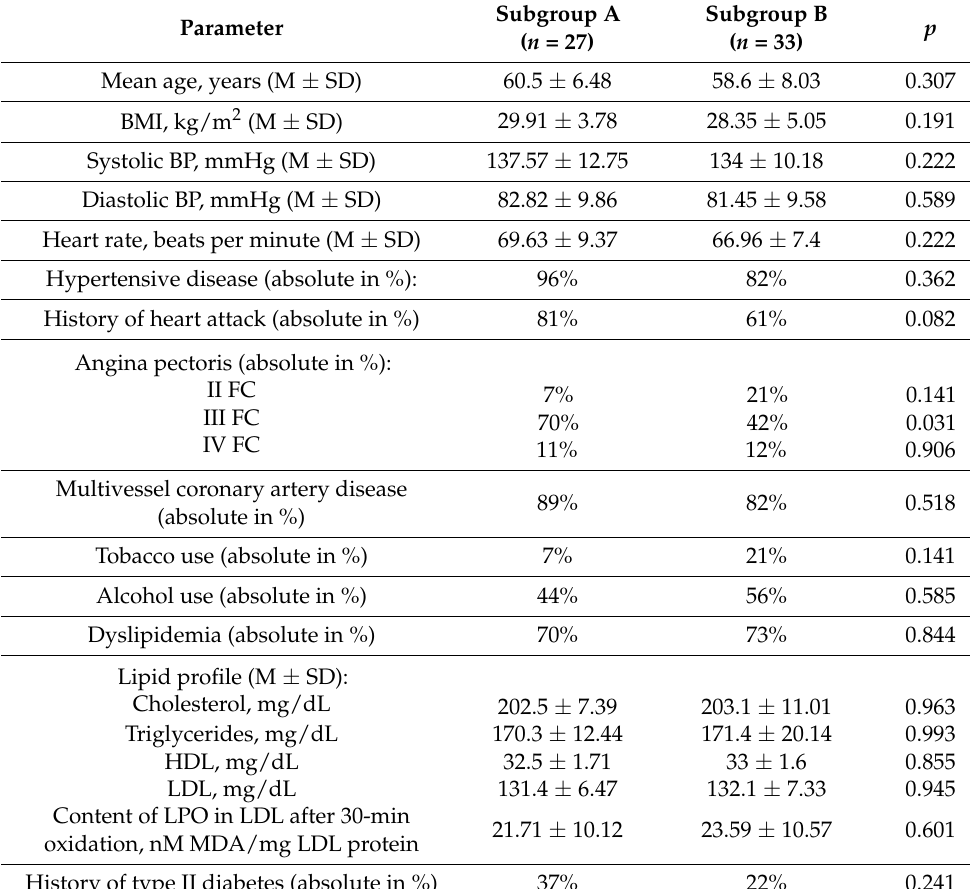
Table 2. Clinical-biochemical characteristics of patients of the